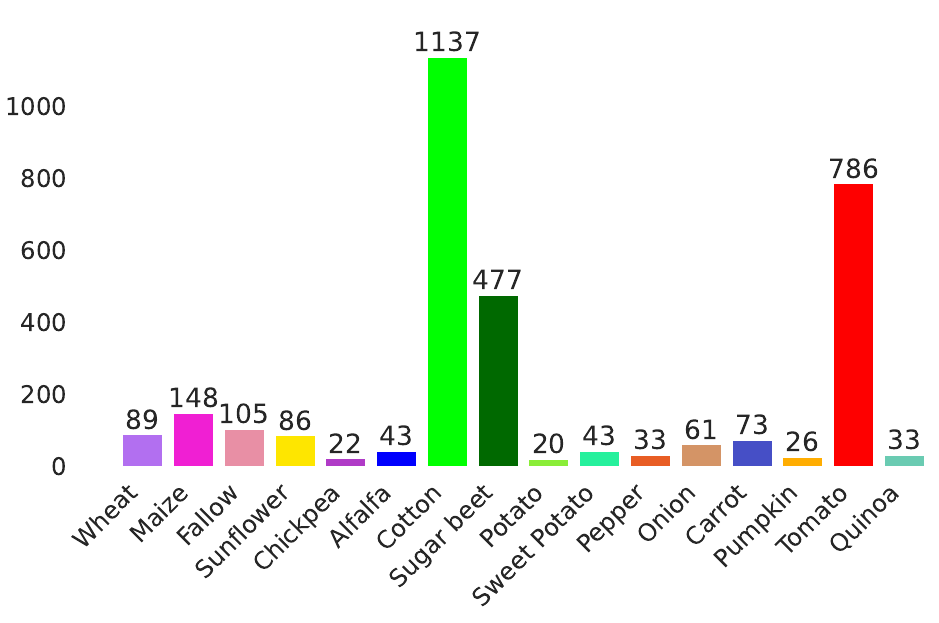
Figure 2. Histogram of referenced crop types distribution (in number of fields).